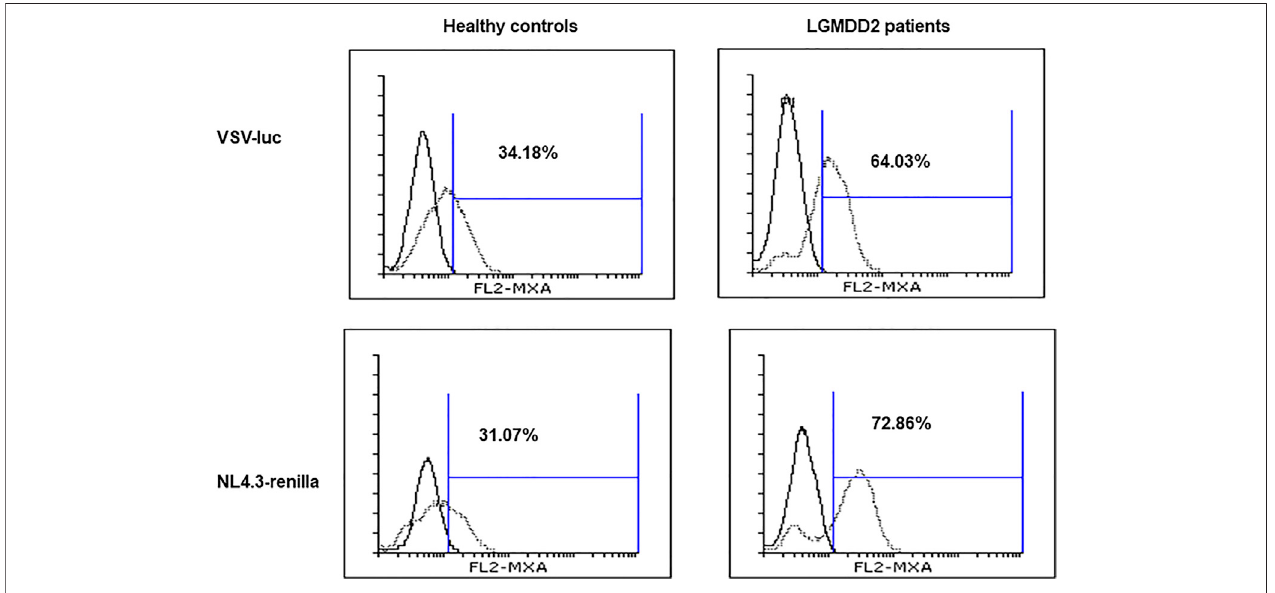
FIGURE 7 | Type I interferon production. PBMCs isolated from healthy controls and LGMDD2 patients were infected by spinoculation with two different HIV-1 strains: VSV-luc and NL4-3_renilla. The production of type I IFN was measured 48 h post infection by quantifying MxA expression by fl ow cytometry.